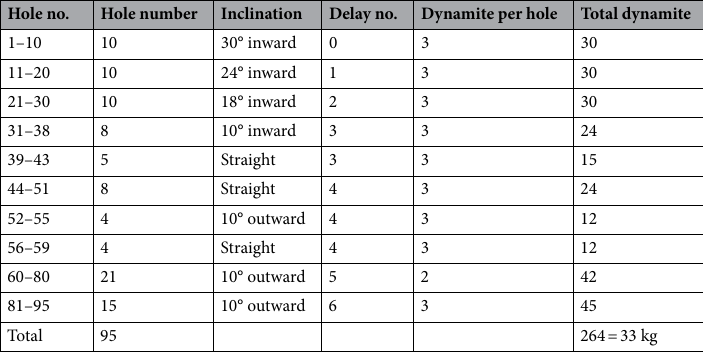
Table 6. Summary of blast pattern with single V-cut for 1.3 m advance at 12.5 m 2 cross-section.